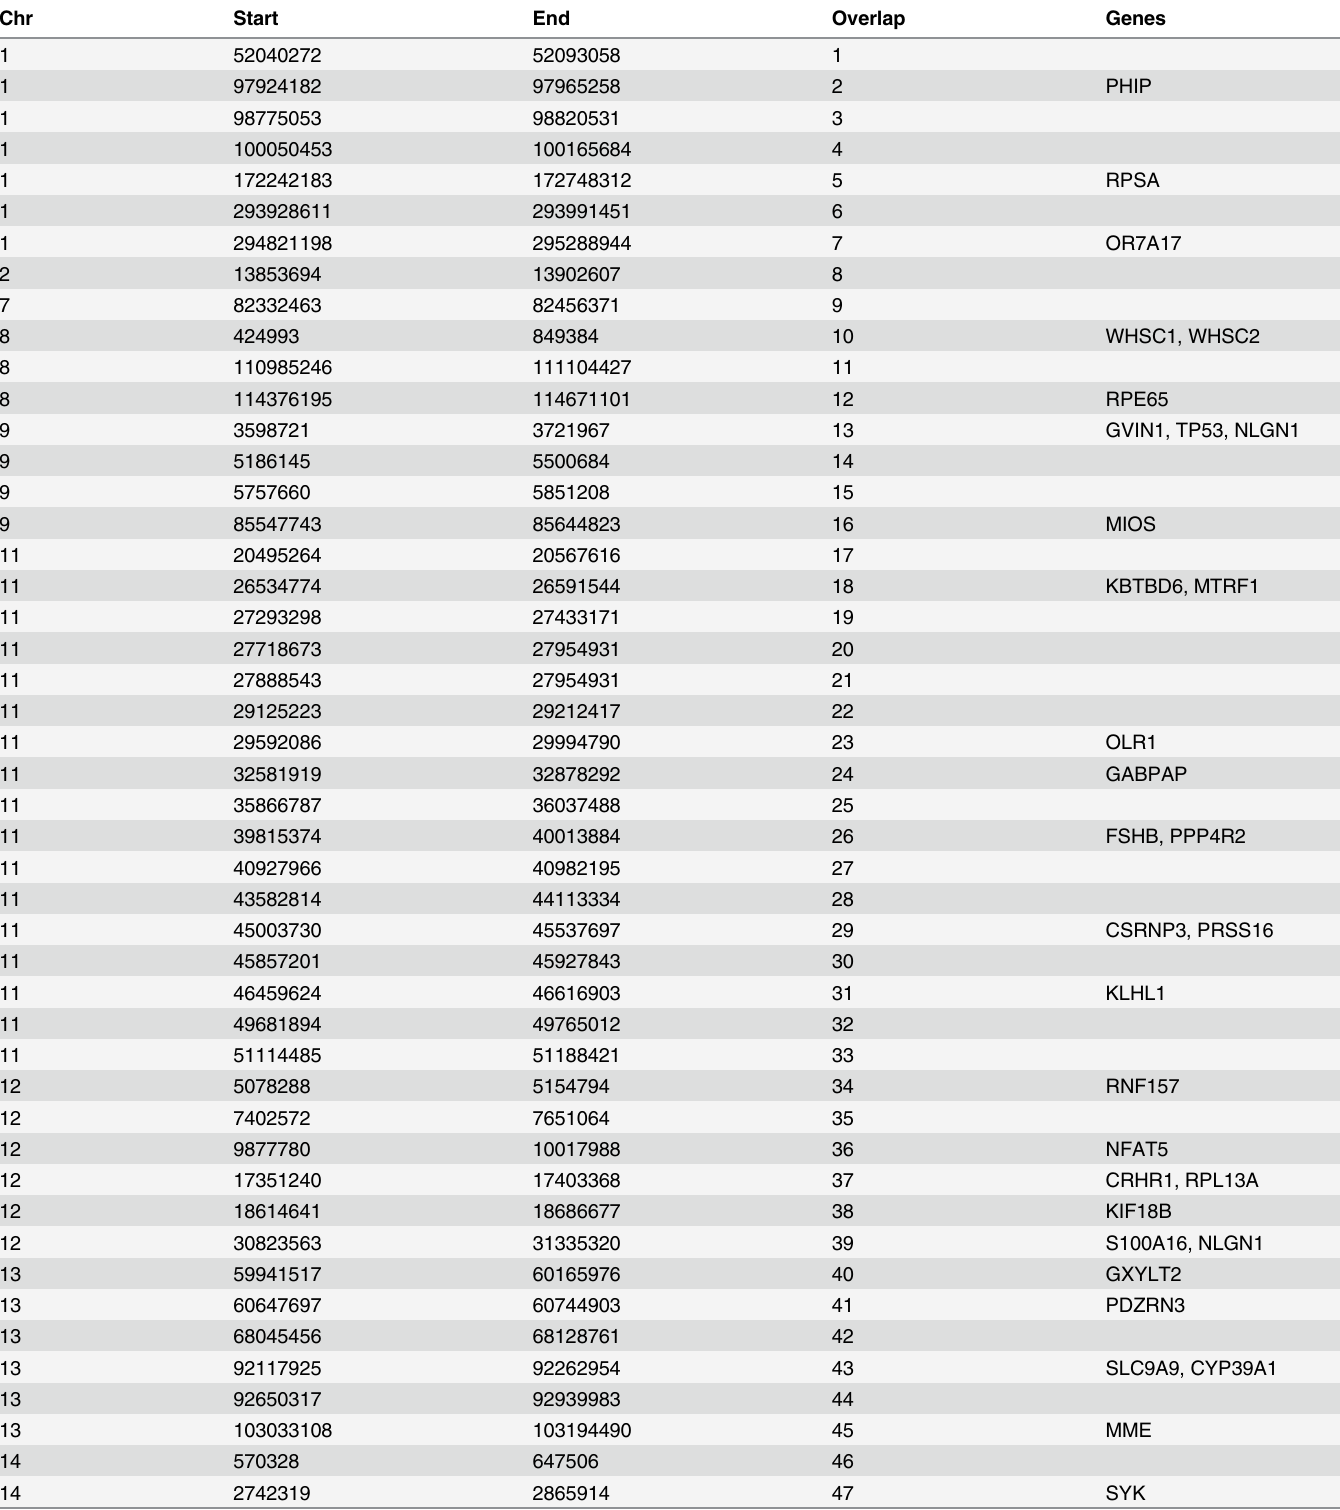
Table 2. CNVR in common across three independent